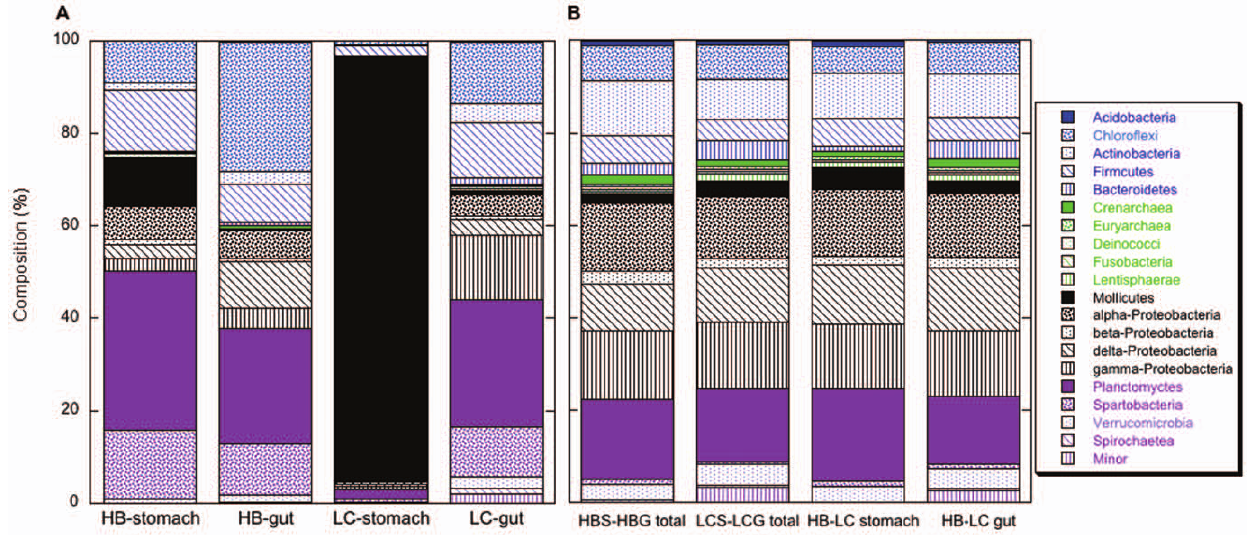
Figure 1. Composition of oyster stomach and gut microbiomes. A. Phylogenetic composition (phyla and classes) of Hackberry Bay (HB) and Lake Caillou (LC) stomach and gut microbiomes based on frequencies of occurrence within the set of all classified sequences. B. As for A, but composition is based on the unweighted abundance of phyla and classes with the 284 classified OTUs (all results from CloVR analysis).